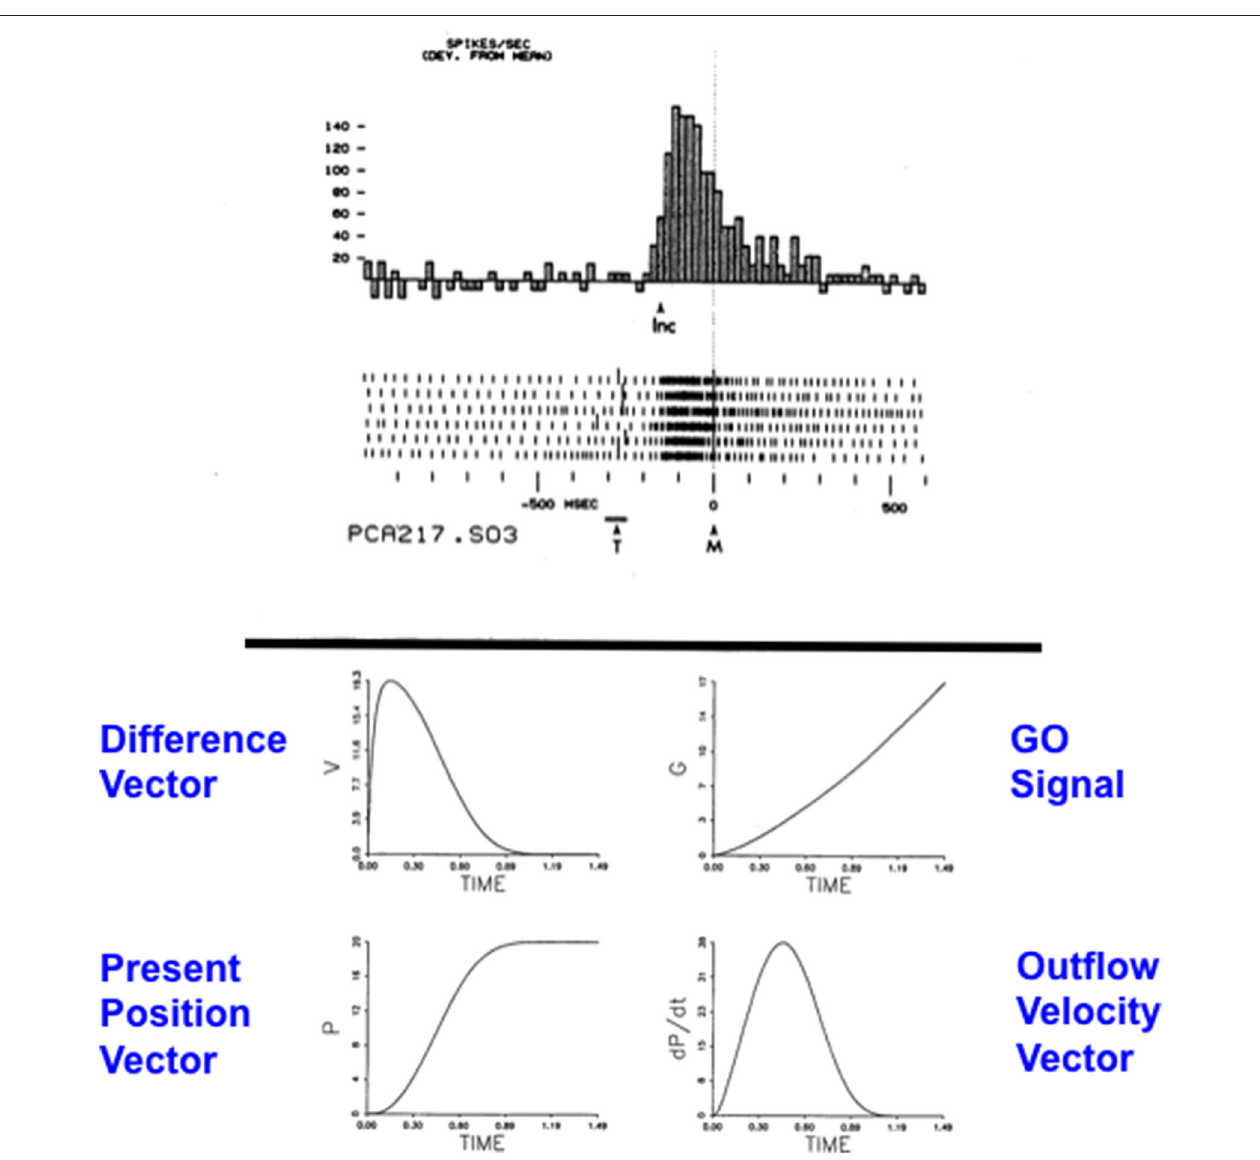
FIGURE 13 | (Top half) Neurophysiological data of vector cell responses in motor cortex. (Bottom half) VITE model simulations of a simple arm movement in which the model’s difference vector D simulates the data as an emergent property of network interactions [data of Georgopoulos et al. (1982) and Bullock and Grossberg (1988) are reproduced with permission. Figure as a whole is reprinted with permission from Grossberg